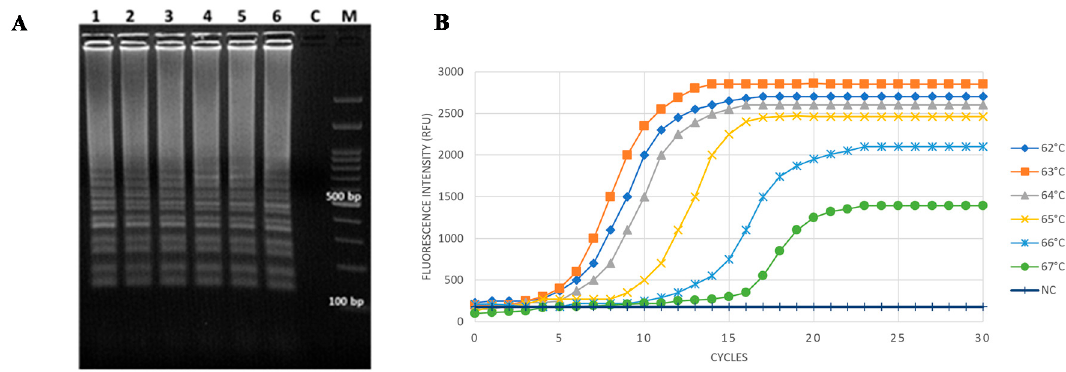
Figure 1. Optimization of LAMP reaction for C ff DNA detection. Isothermal amplification was carried out on C ff ICMP 2584 T DNA (40 ng / reaction) used as a template, and at temperatures ranging from 62 ◦ C to 67 ◦ C. Data assessment was based on 2% agarose gel electrophoresis analysis ( A ) and real-time fluorescence monitoring ( B ). ( A ) M - Gene Ruler 100 pb Plus DNA Ladder; C = negative control; lanes 1 to 6: amplicons in the temperature range 62 ◦ C–67 ◦ C. ( B ) Optimization of reaction time, according to real-time fluorescence amplification plots; NC = negative control. 1 cycle = 1 min reaction.